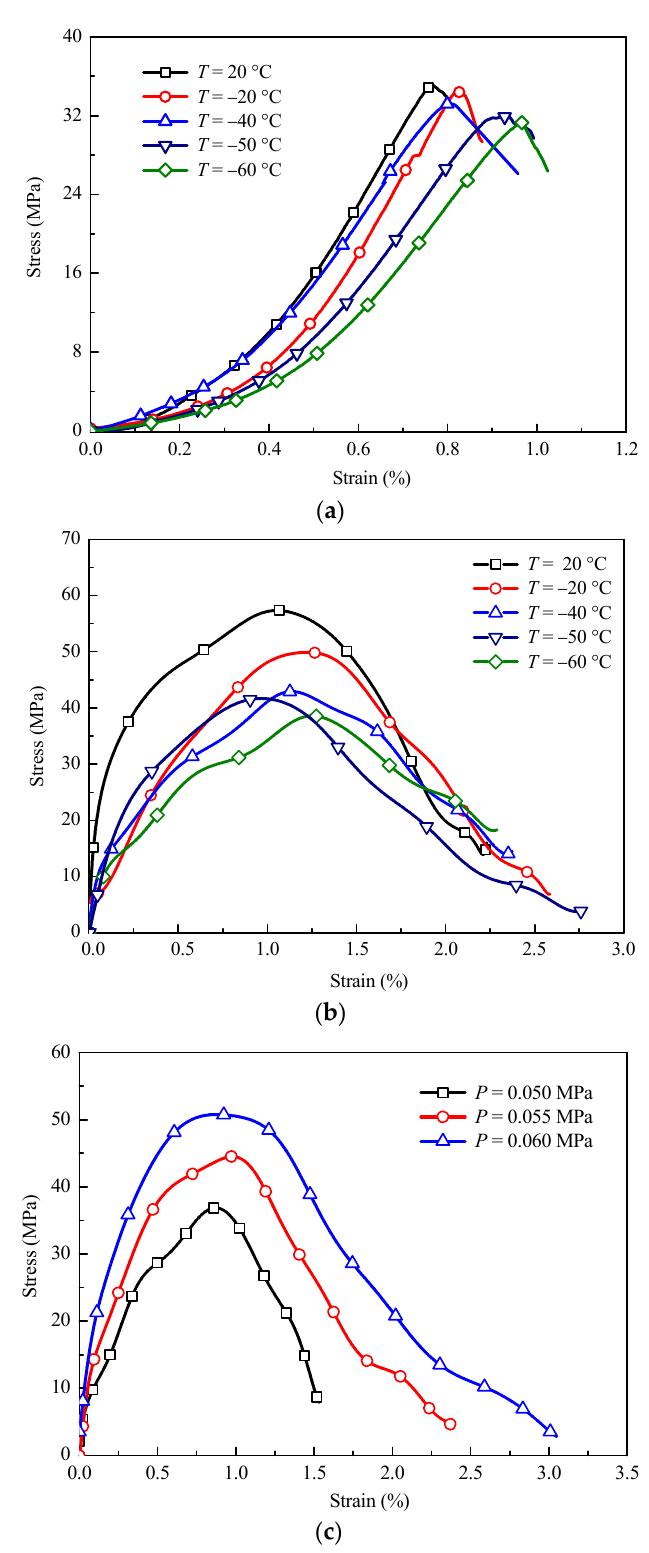
Figure 5. Stress–strain curves. ( a ) Static stress–strain curves at different freezing temperature. ( b ) Dynamic stress–strain curves at different freezing temperature. ( c ) Dynamic stress–strain curves at different impact pressures.